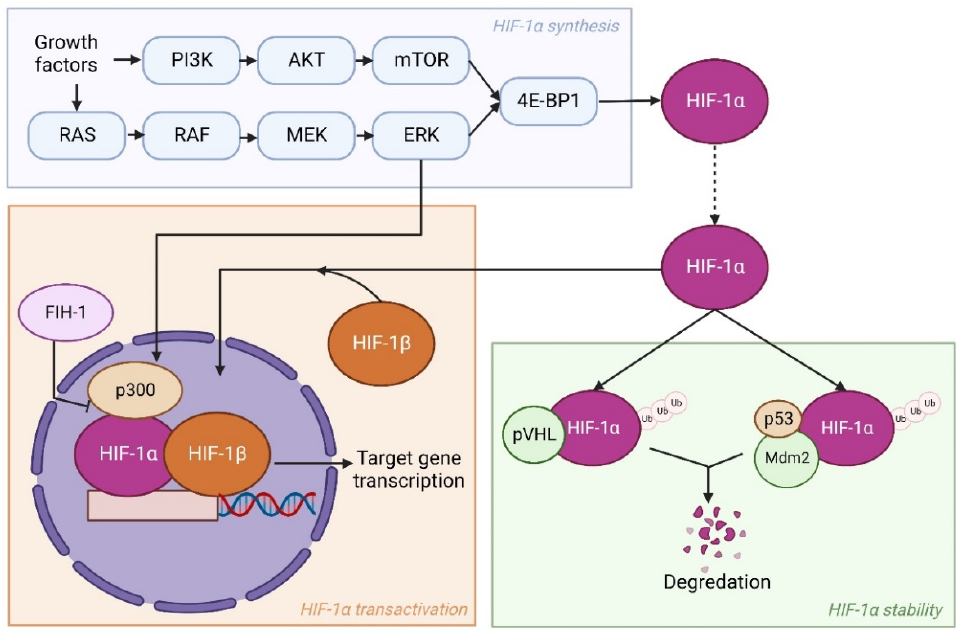
Figure 1. HIF-1 α regulation by altering HIF-1 α synthesis, stability, or transactivation. The HIF-1 α synthesis is mediated by the PI3K-AKT pathway and the RAS/RAF/MEK/ERK kinase cascade upon activation by growth factors. Afterwards, HIF-1 α is either degraded via pVHL or p53/Mdm2 related ubiquitination, or it translocates to the nucleus. There, it forms a heterodimer with HIF-1 β and is coactivated by p300 leading to transcriptional activation of target genes. This can be enhanced by ERK expression or inhibited by FIH-1. Created with BioRender.com, accessed on